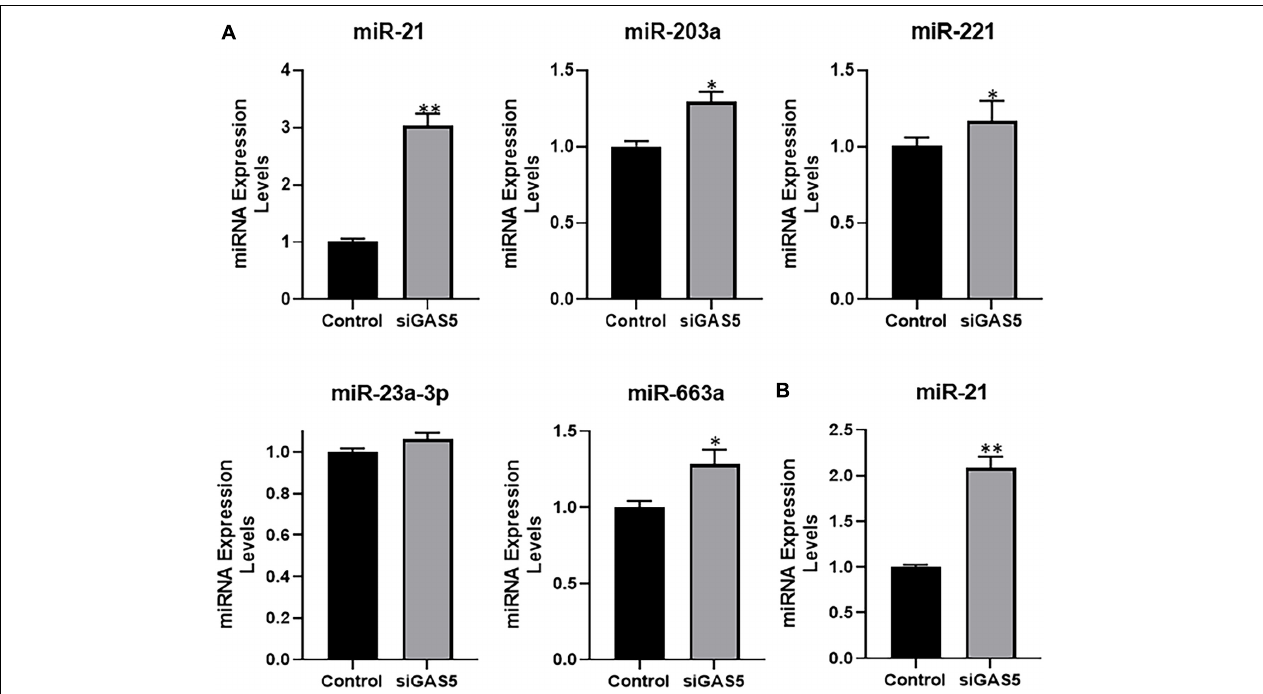
FIGURE 4 | Growth arrest specific 5 (GAS5) sponges miR-21. (A) GAS5 was downregulated by small-interfering RNA (siRNA) in U2OS cells, and the resulting effects on the expression of different miRNAs were analyzed. (B) GAS5 was downregulated by siRNA in hFOB 1.19 cells, and the resulting effect on the expression of miR-21 was analyzed. Control cells (without GAS5 silencing) were assigned a value of “1,” and the corresponding differences in GAS5-silenced cells are shown. * p < 0.05 and ** p <